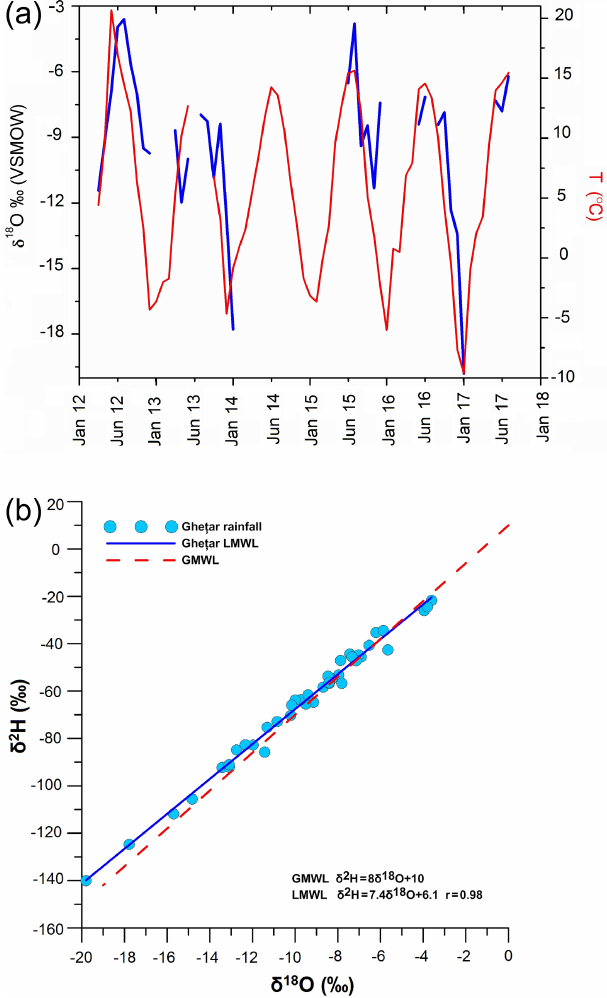
Figure 3. (a) Temporal variability of δ 18 O and δ 2 H in precipitation and air temperature at Ghe¸tar (10km south of the Focul Viu Ice Cave and at the same altitude). (b) The Local Meteoric Water Line (LMWL) of precipitation at the same station, plotted against the Global Meteoric Water Line